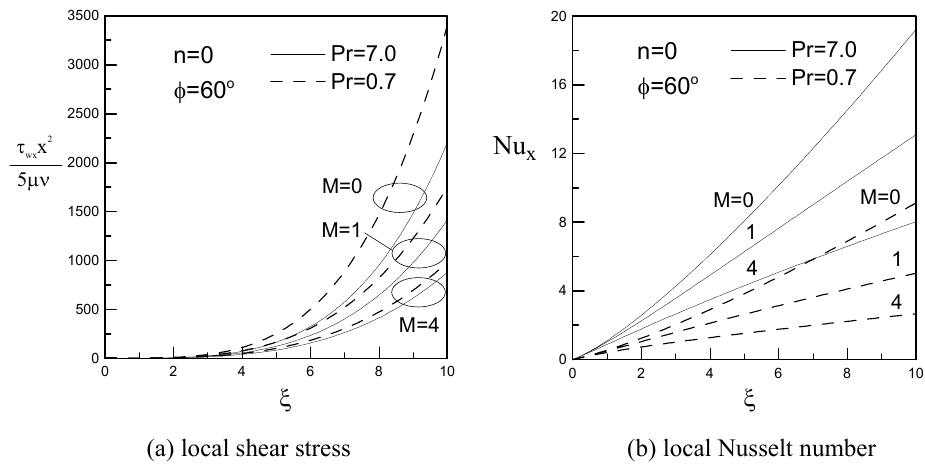
Figure 6 The (a)local shear stress and (b)Nusselt number over a wide range of ξ  for specified M=0, 1, 4 with φ =60°, n=0 and Pr=0.7, 7.0. The effect of magnetic parameter M on the local wall shear stress τ and local Nusselt wx over a wide range of ξ for Pr=0.7 and 7.0 at n=0 and φ =60° is shown in Fig. 6. number Nu x When ξ is increased, the local wall shear stress and Nusselt number are increased. As indicated in Fig. 3, the magnetic field tends to impede the flow motion and reduces the temperature gradient near the wall. Thus, the local wall shear stress and Nusselt number decrease as M increases. For example, the local Nusselt number at M=4 decreases 71% for Pr=0.7 and 58% for Pr=7.0 relative to the values of M=0. Figure 7 illustrates the effect of magnetic parameter M on the average wall shear stress ( µντ 5/L 2 ) and average Nusselt number ( Nu ) for specified Prandtl number (Pr=0.01, w 0.7, 7.0, 100) and exponent n (n=-1/3, 0, 1/3, 1) at inclination angle φ =60°. The expressions of ( µντ 5/L 2 ) and ( Nu ) are defined in Eqs. (12)-(13). It clearly indicates that the w average wall shear stress and average Nusselt number dramatically decrease as M increases. The trends are gradually retarded when M is larger than 1. In addition, the fluids with a larger Pr have higher Nu and lower µντ 5/L 2 . A closer look shows that the magnetic w and Nu is more pronounced for lower Prandtl number field effect on the µντ 5/L 2 w fluids. The corresponding data from Fig. 7 and comparisons of Nu / Nu are tabulated (M=0) in Table 1. For a specified n value, the magnetic field effect on Nu is gradually more important as Pr decreases. For example, for the isothermal plate (n=0), the value of Nu / Nu for Pr=100 is 72.5%, while it is 42.5% for Pr=0.01. For constant heat flux (M=4) (M=0) condition (n=1/3), the value of Nu / Nu for Pr=100 is 82.5%, while it is 60.1% for (M=4) (M=0) Pr=0.01. Table 1 also indicates that the magnetic field effect on Nu is more important for the cases of smaller n. For example, for Pr=0.01, the value of Nu / Nu for n=1 is (M=4) (M=0) 82.2%, while it is only 16.7% for n=-1/3. In conclusion, for the cases of lower n and Pr, the magnetic field effect plays a more important role on the MHD free convection flow on horizontal and inclined